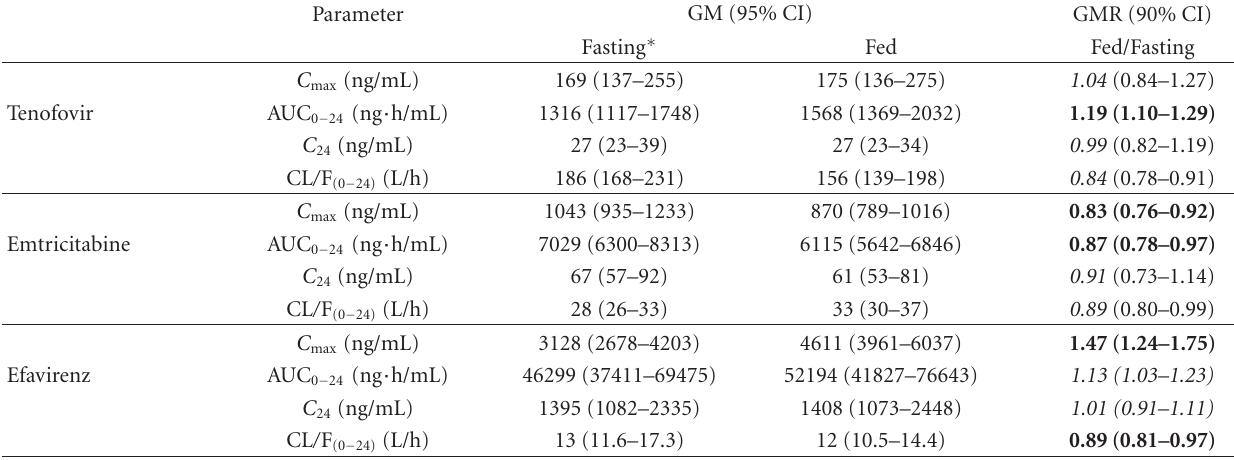
Table 2: Pharmacokinetic parameters and comparisons during tenofovir and emtricitabine plus efavirenz administration in the fasting (Day 1) and fed (Day 8)